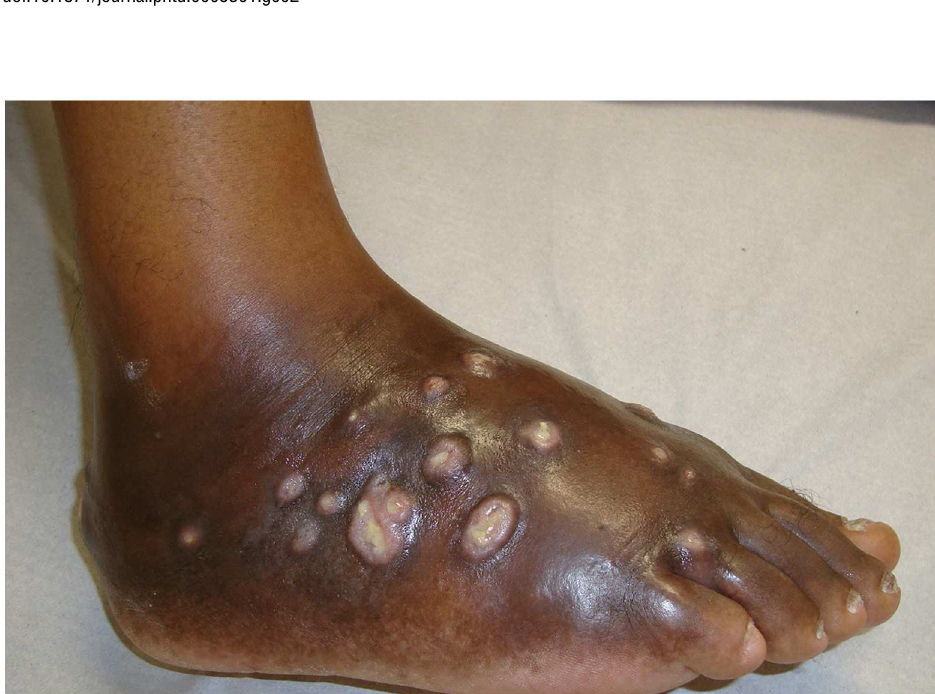
Fig 3. Foot affected with actinomycetoma.